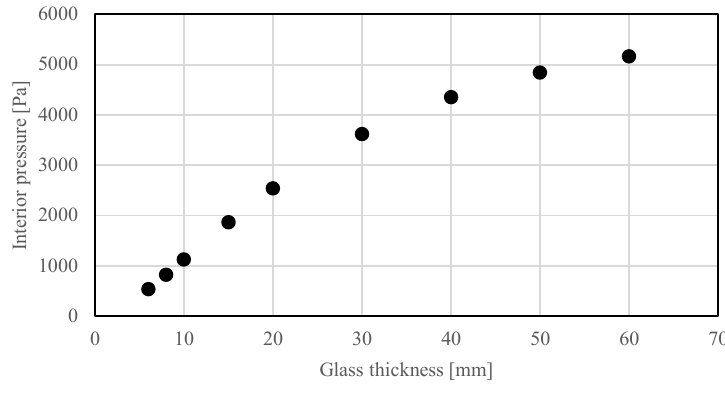
Fig. 4 Internal pressure vs. glass thickness for the reference cylindrical panel of the parametric study.